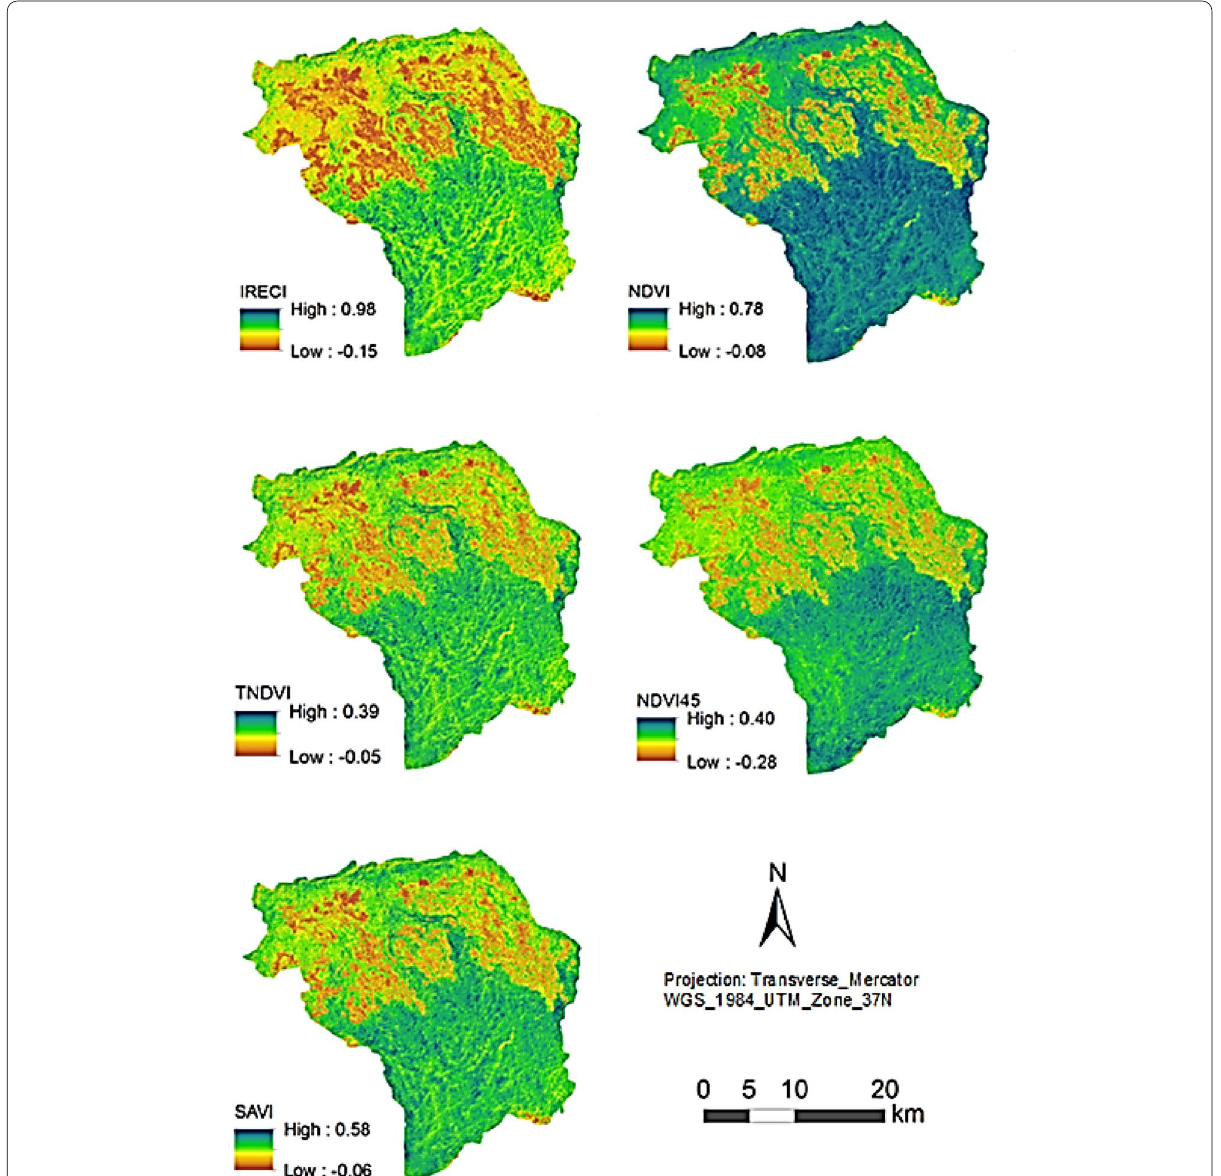
Fig. 5 Maps of the vegetation indices showing the highest and lowest spectral values computed from combination of bands indicating distribution of green